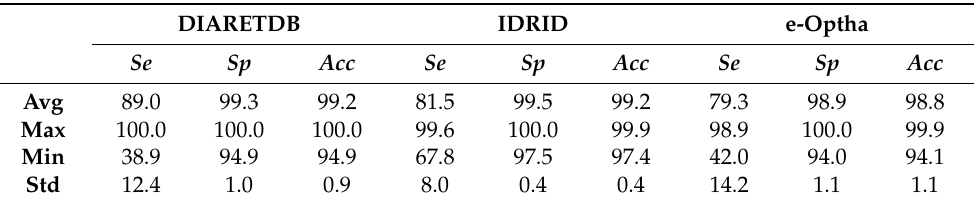
Table 2. Statistical readings of exudate segmentation for the implemented